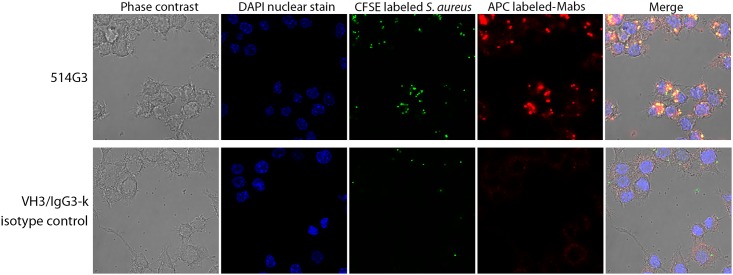
514G3 mediated antibody dependent S. aureus phagocytosis.A. Visualization of opsonophagocytic uptake of S aureus by RAW264.7 cells. S. aureus were labeled with CFSE (Green), 514G3 (top panel) or VH3/IgG3-k isotype control (bottom panel) was conjugated with APC (Red) and nuclei was stained with DAPI (Blue). The stained cells were imaged on a confocal microscope by focusing on the center of the macrophage to visualize only the bacteria that have been internalized. The top panel shows co-localization of the bacteria and 514G3 as yellow-orange dots inside the cytoplasm of the RAW 264.7 cells. The bottom panel shows that the isotype control does not promote significant opsonophagocytosis as seen by the absence of yellow-orange dots inside the cells.